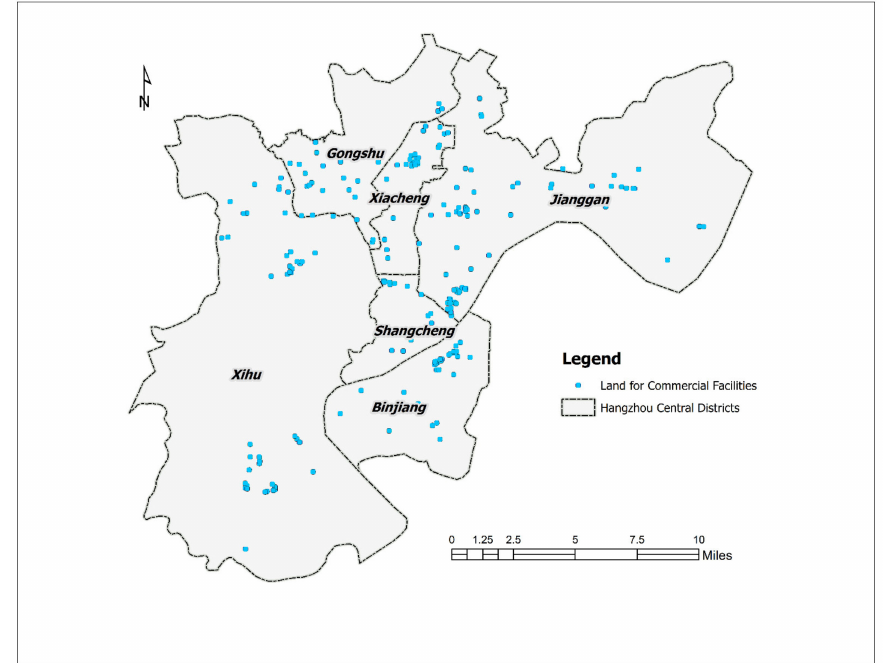
Figure 3. Sample distribution in the study area.